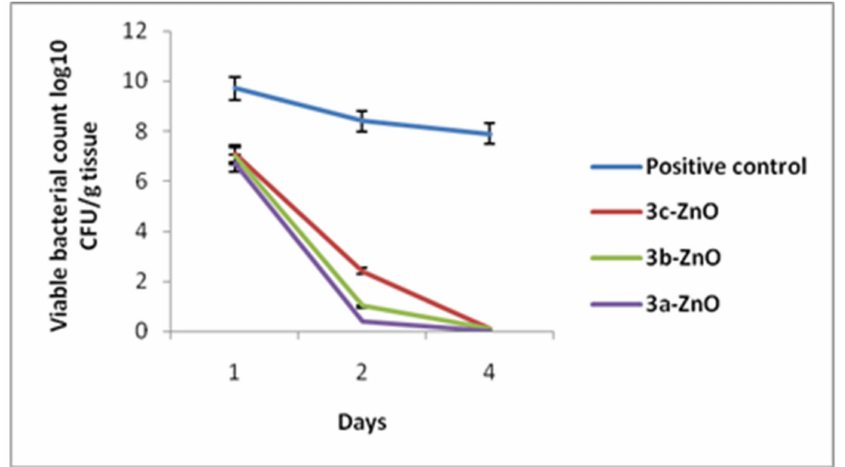
Figure 12. Bacterial load assessment in the lungs of pneumonic rats.